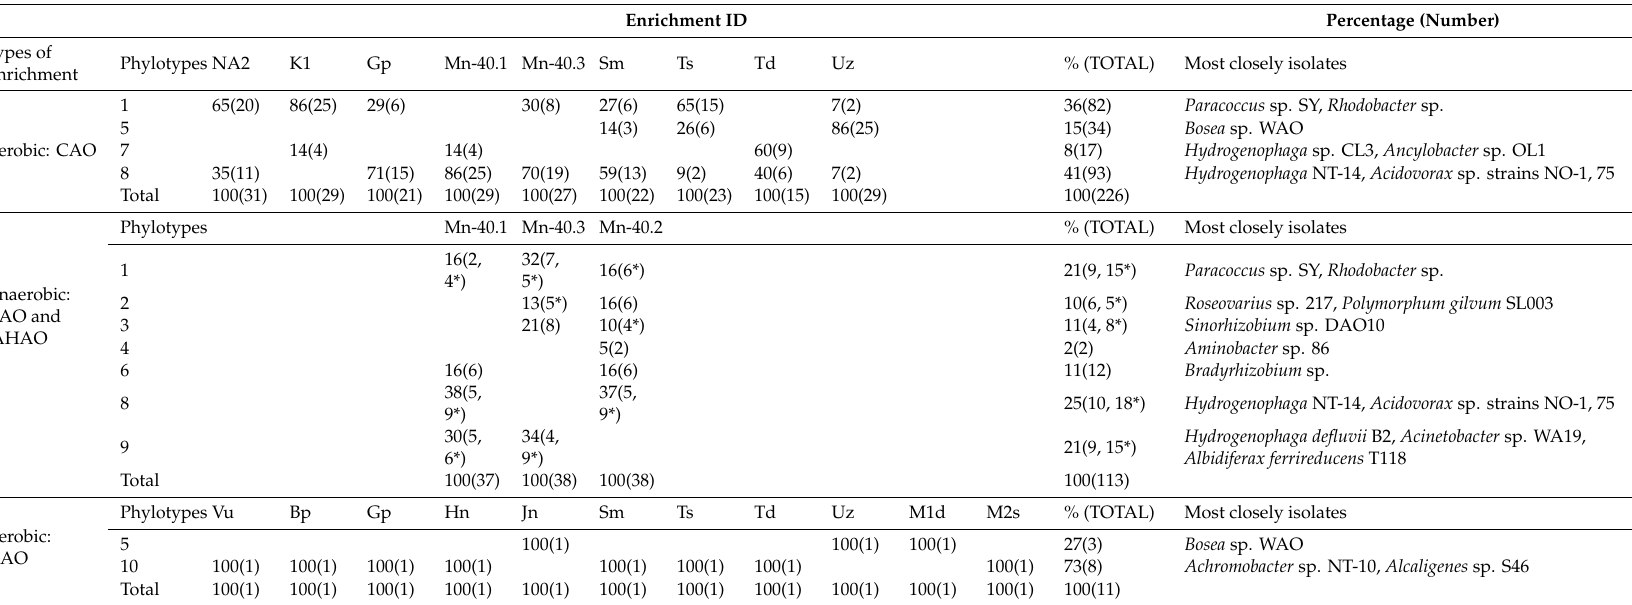
Table 2. Contribution (in percentages) of various phylotypes to aioA gene-based clone libraries prepared from four di ff erent types of arsenite-oxidizing enrichment initiated with the groundwater samples from Bangladesh. The enrichment codes refer to the location of the drinking water well (see Table 1 for detailed information). Between parentheses is the number of clones. *AHAO: anaerobic chemoorganoheterotrophic arsenite-oxidizing enrichment [with added acetate]. Phylotypes 1–7 belong to Alphaproteobacteria and 8-10 belong to Betaproteobacteria (see Figure